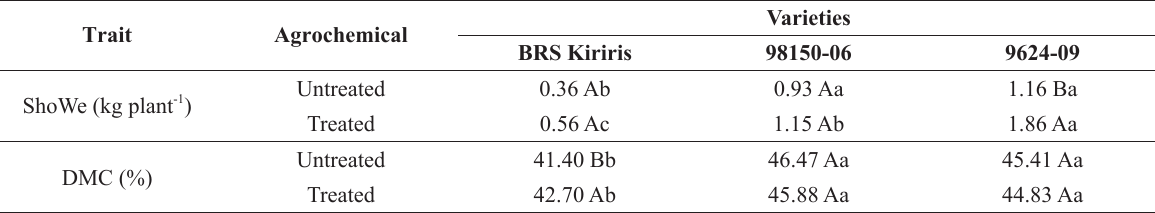
ShoWe - shoot weight per plant, and DMC - dry matter content of the